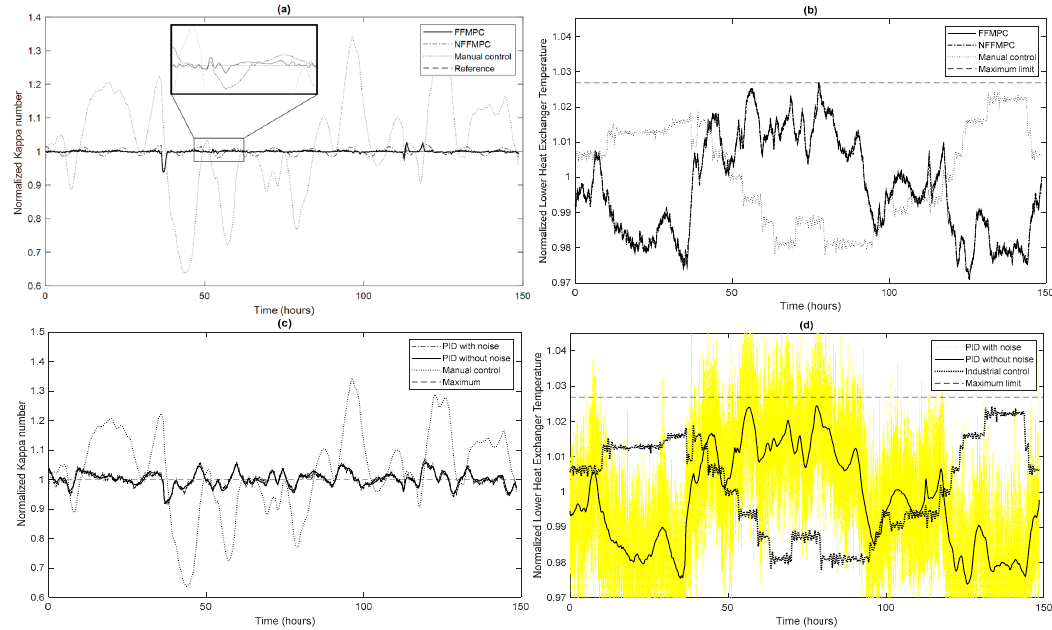
Figure 9. Comparison of MPC ( a ) response and ( b ) control effort against the PID ( c ) response and ( d ) control effort. Table 1. Average output error for all the cases.